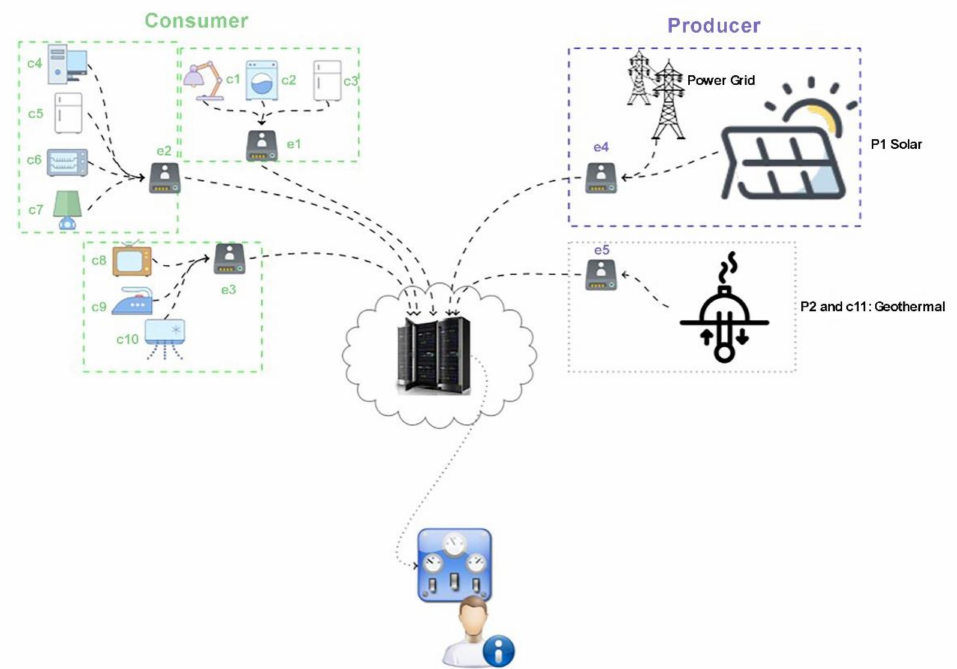
Figure 14. Operative